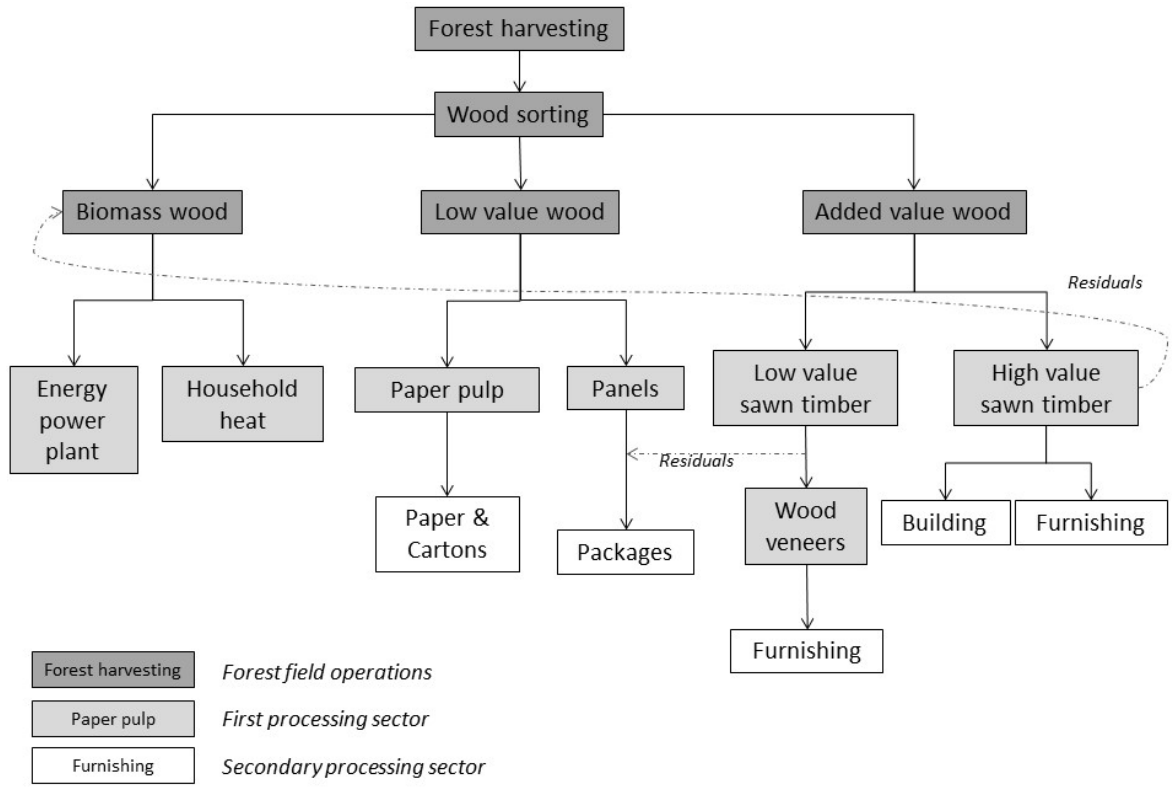
Figure 2. Simplified description of a structured and diversified forestry sector. As it was stated by most of PACA forest actors “ A more profitable and structured forestry sector should involve a regional wood supply chain with both first and secondary processing sector of transformation ”. Yet, the development of a secondary processing sector requires wood with higher added value, necessitating management plans for selection of young trees with high potential value, wood sorting once trees are cut to select high value lumber, and technical structures.